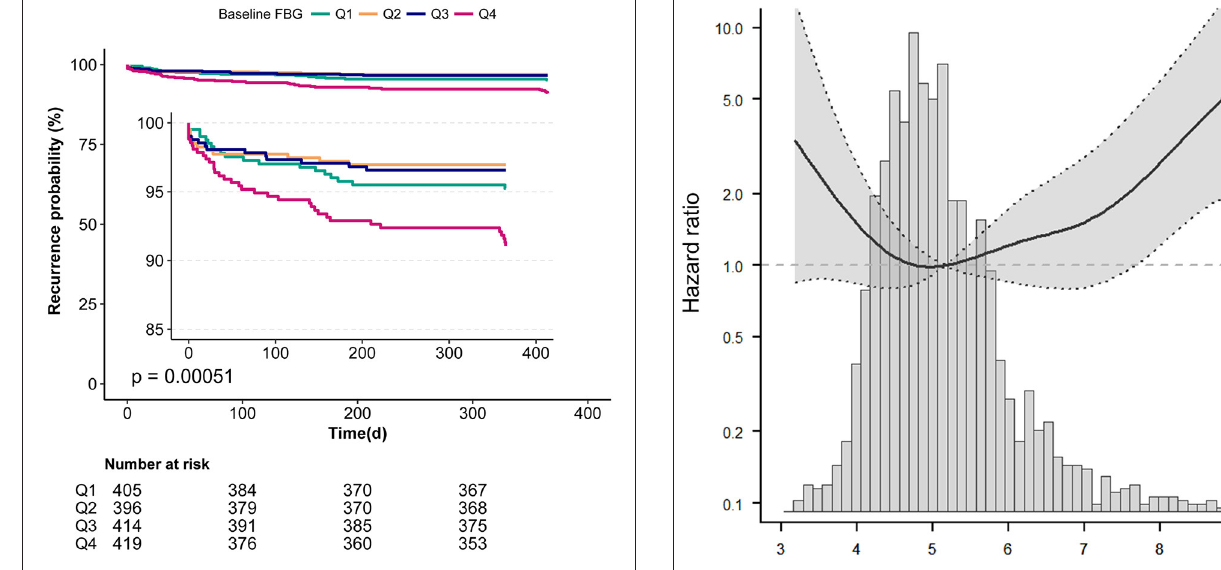
FIGURE 2 | Kaplan-Meier analyses of the relationship between baseline FBG and 1-year stroke recurrence in non-diabetic patients with ACI.